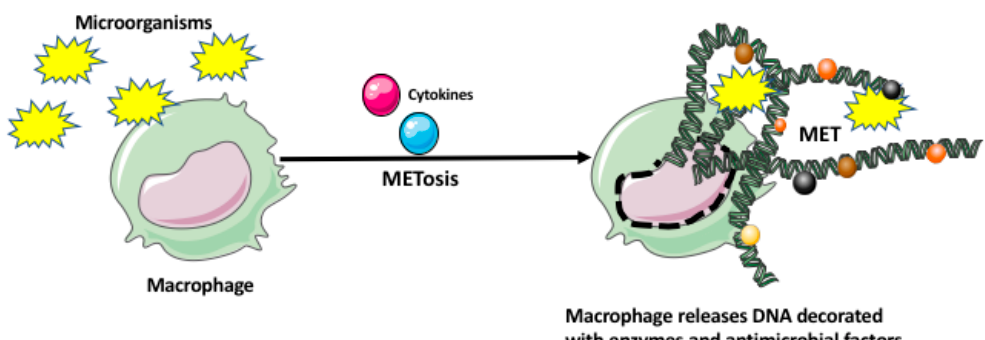
Figure 2. Macrophage extracellular trap (MET) formation by macrophage. The microorganisms and/or various cytokines may induce a unique cell death program in the macrophage, called METosis. The METosis causes breakage of the macrophage nuclear envelope and release of strands of DNA, which form the MET decorated with the enzymes and antimicrobial factors.